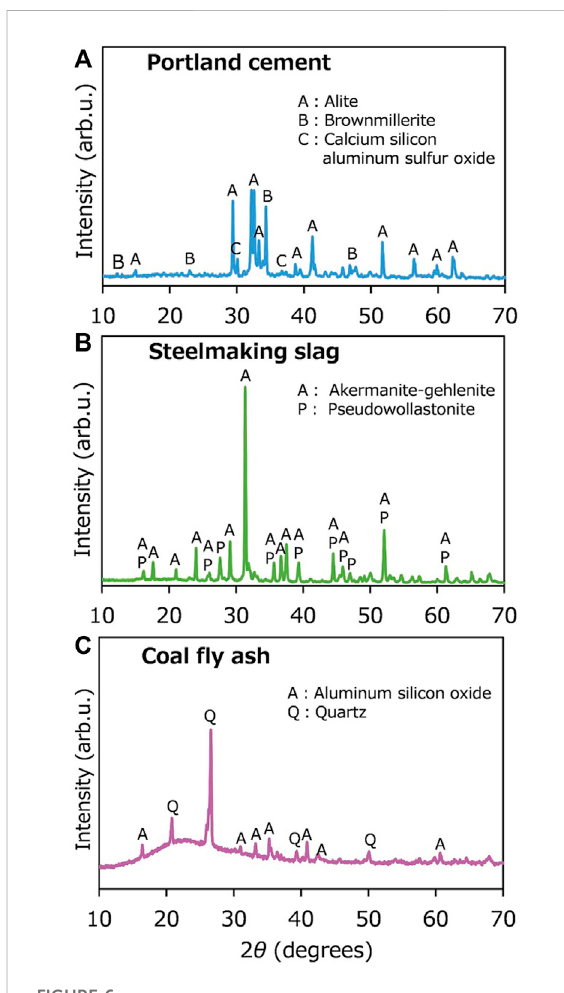
FIGURE 6 X-ray diffraction patterns observed for (A) Portland cement, (B) steelmaking slag, and (C) coal fl y ash.